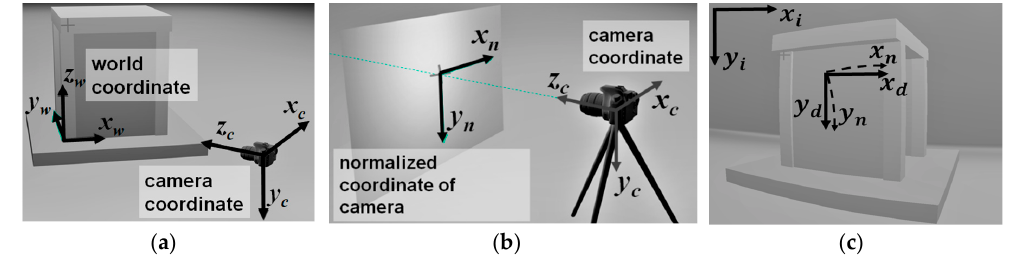
Figure 1. Di ff erent coordinate systems used in image analysis. Image measurement involves Figure 1. Different coordinate systems used in image analysis. Image measurement transformation between di ff erent coordinate systems. ( a ) From world coordinates to camera coordinates. involves transformation between different coordinate systems. ( a ) From world coordinates ( b ) From camera coordinates to normalized coordinates. ( c ) From normalized coordinates to distorted to camera coordinates. ( b ) From camera coordinates to normalized coordinates. ( c ) From and image normalized coordinates to distorted and image coordinates.